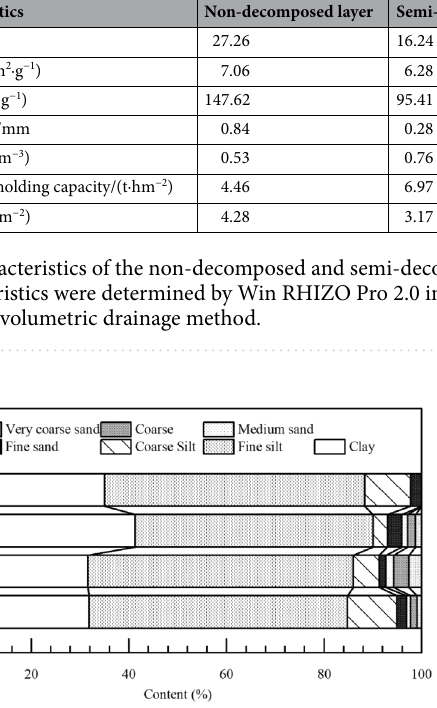
Figure 2. Soil particle composition of study area soil